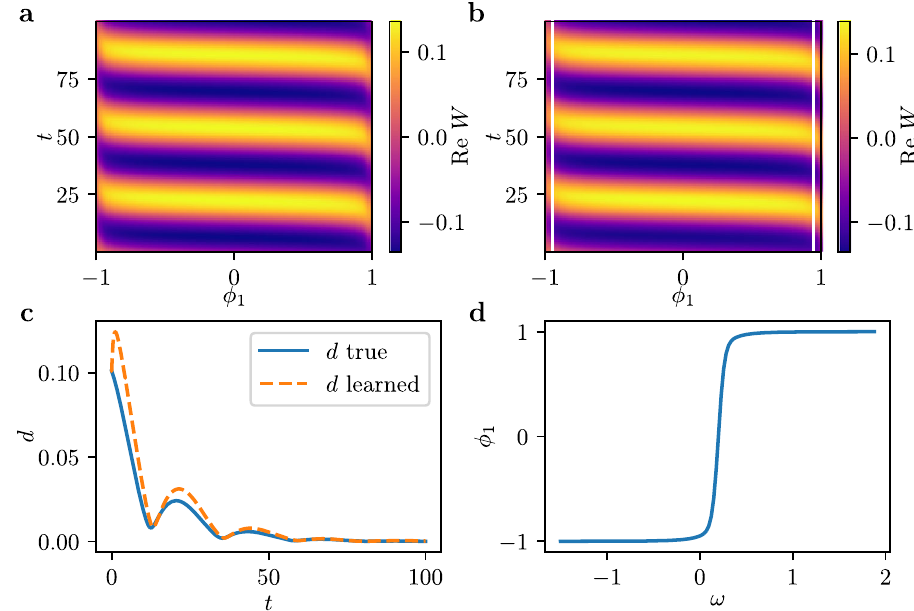
Fig. 3 Emergent PDE for an ensemble of Stuart-Landau oscillators. a Real part of the complex variable W for a system of N = 512 oscillators, parametrized by the fi rst emergent diffusion mode ϕ 1 . b Dynamics obtained from the learned model by integrating starting from the same initial snapshot as in ( a ). c Smallest Euclidean distance d in C N at each time step between the transients and the true attractor for the true PDE (blue) and the learned PDE (orange). d The fi rst diffusion mode ϕ 1 as a function of the intrinsic frequencies ω of the oscillator ensemble.